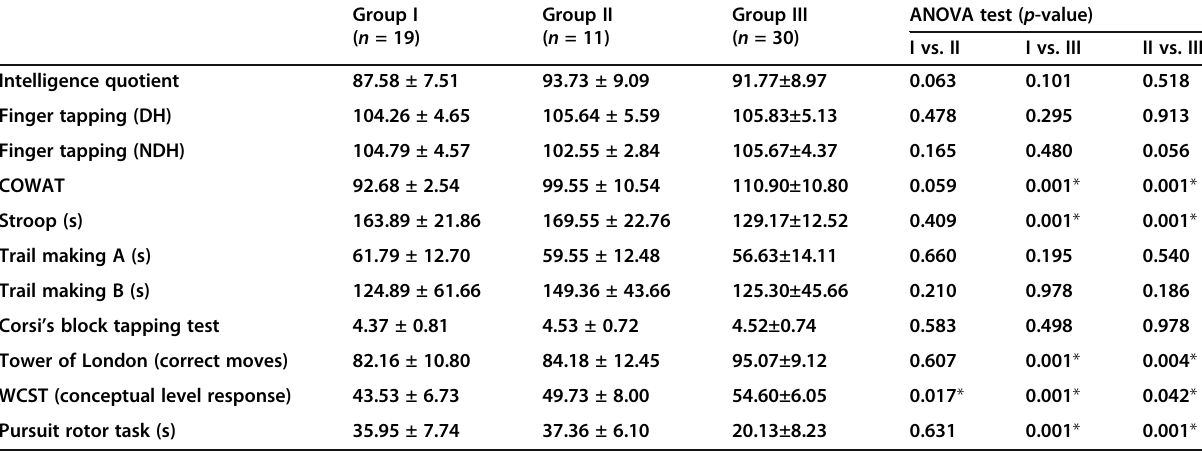
Table 2 Comparison between studied groups in cognitive tests